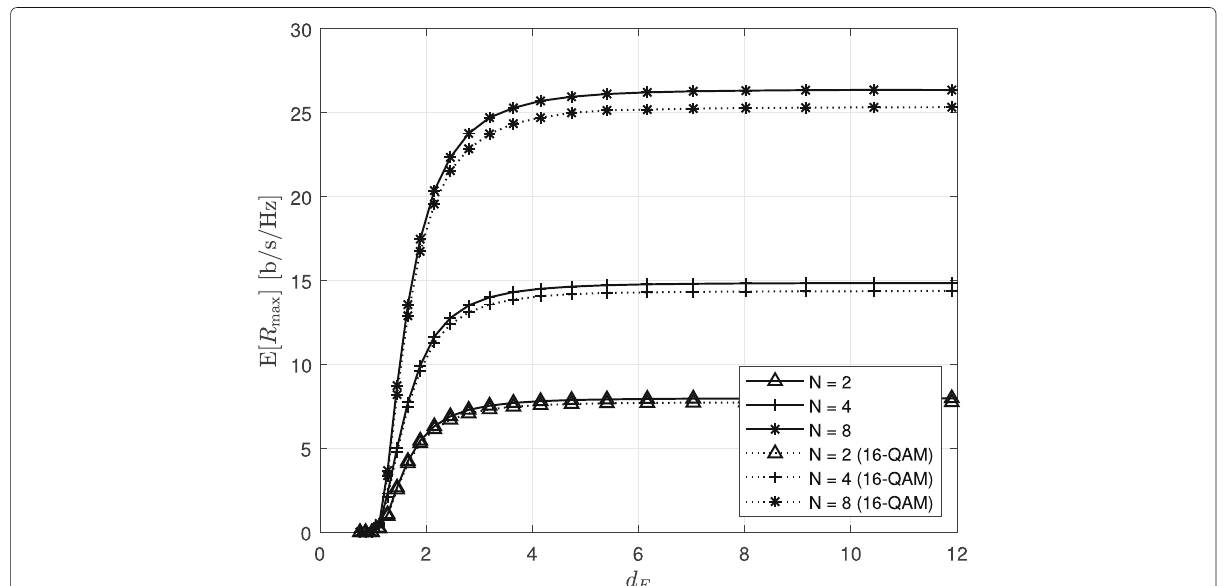
Fig. 8 Average maximum secrecy rate as a function of d E with infinite-length coding, both Gaussian signaling and discrete (16-QAM) constellations and various values of N